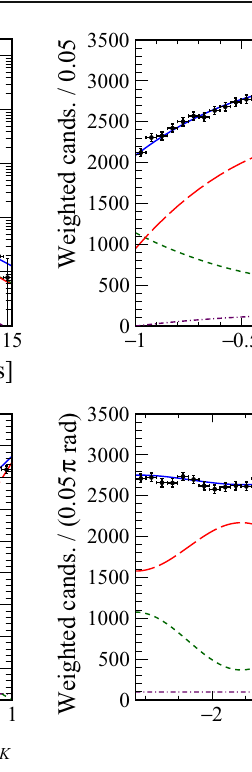
(long-dashed red) CP -even, (short-dashed green) CP -odd and (dotted- dashed purple) S-wave contributions. Data and fit projections for the different samples considered (data-taking year, trigger and tagging cat- egories, m ( K + K − ) bins) are combined